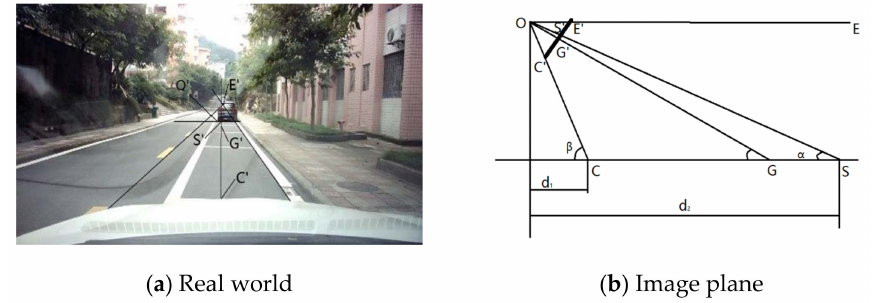
Figure 11. The real world and the image